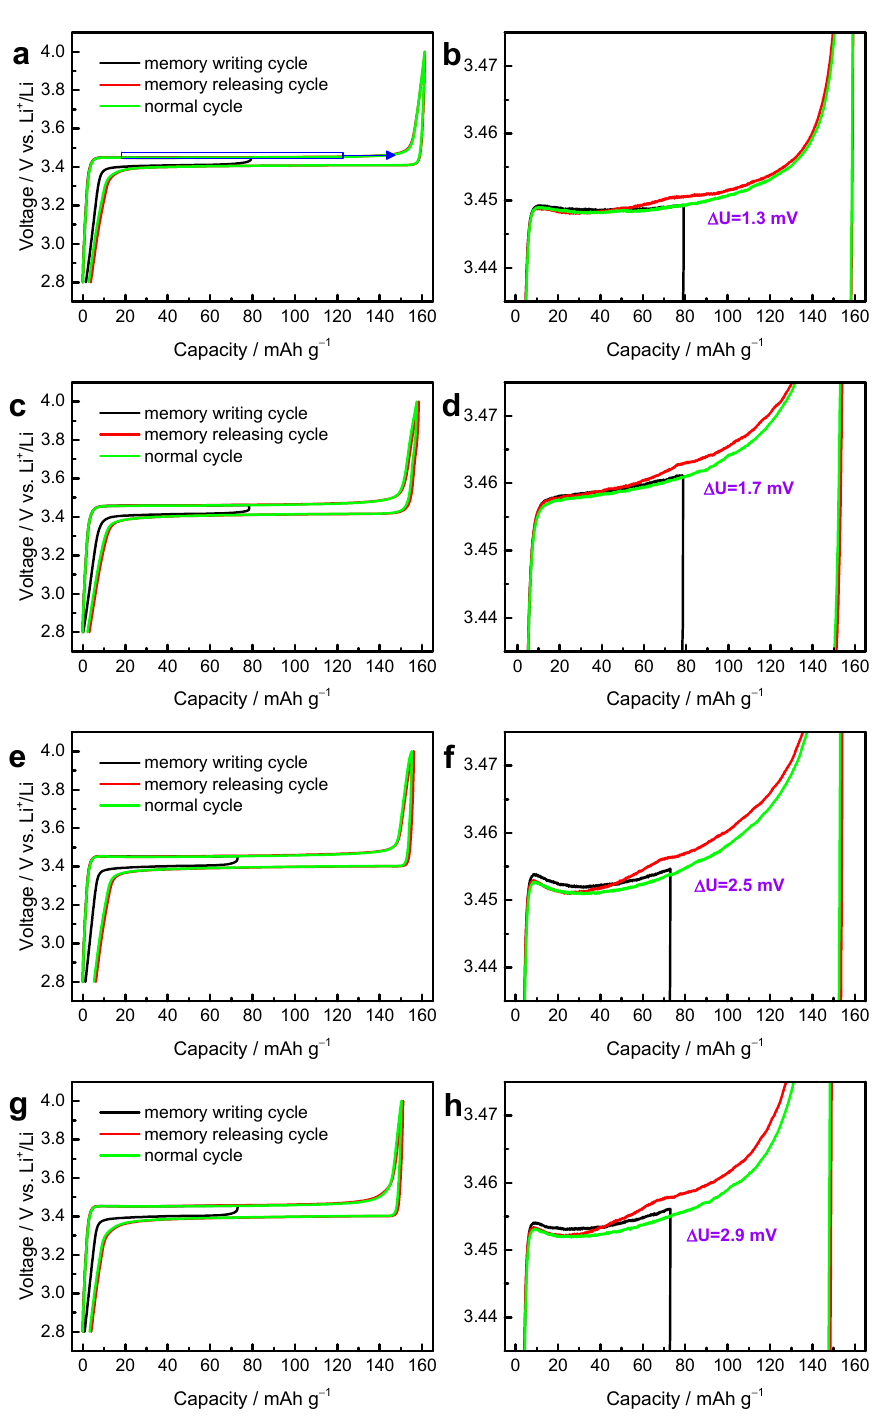
Figure 8. Determination of the memory effect during charging for LiFePO 4 . For memory effect during charging, the memory-writing cycle was a half-charge from 2.8 V and a discharge to 2.8 V (black); the memory-releasing cycle (red) and normal cycle (green) were a full charge–discharge from 2.8 V to 4.0 V. The memory effect is shown for LiFePO 4 samples prepared at spray drying temperatures of ( a , b ) 200 ◦ C, ( c , d ) 250 ◦ C, ( e , f ) 300 ◦ C and ( g , h ) 350 ◦ C during charging, as well as ( b , d , f , h ) enlarged view of ( a , c , e , g ), respectively. Here, the current rate was